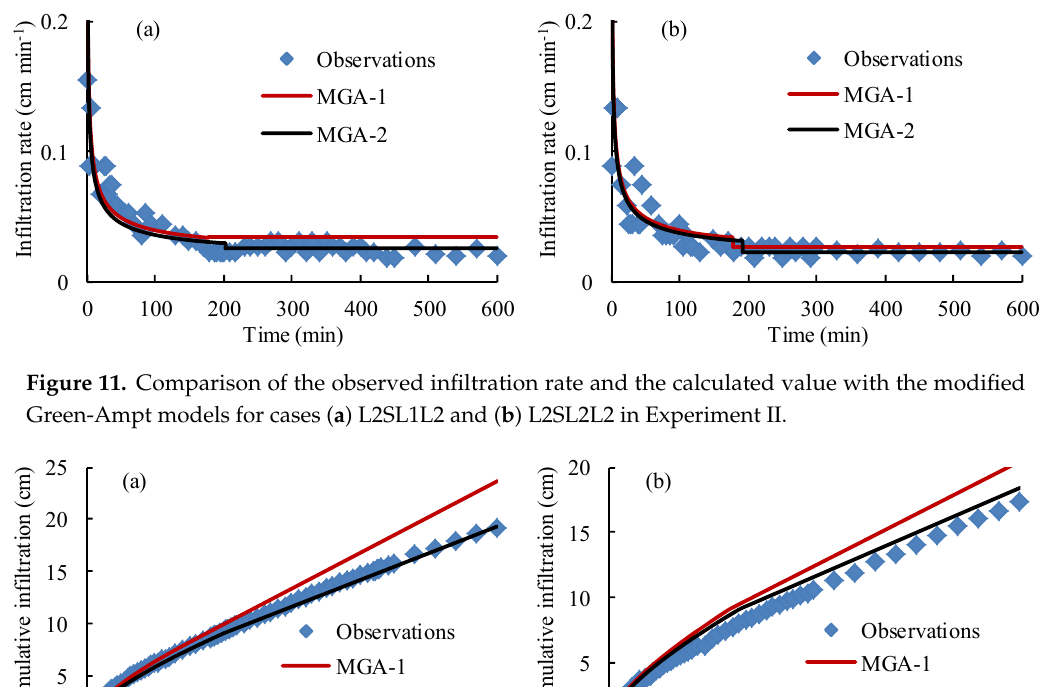
Figure 12. Comparison of the observed cumulative infiltration and the calculated value with the modified Green-Ampt models for cases ( a ) L2SL1L2 and ( b ) L2SL2L2 in Experiment II.